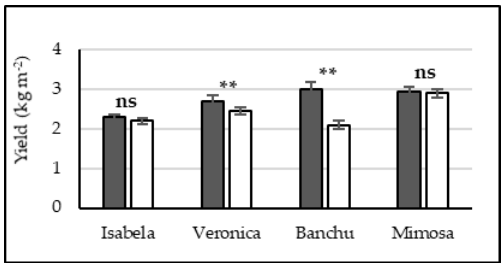
Figure 3. Results from experiments 3 (NE-Brazil). Yield response to the simplified soilless system orientation (east, grey columns; west, white columns) in four lettuce cultivars (Isabela, Veronica, Banchu, and Mimosa). Vertical bars represent standard errors. Significant differences at p ≤ 0.01 (**), ns = not significant differences.